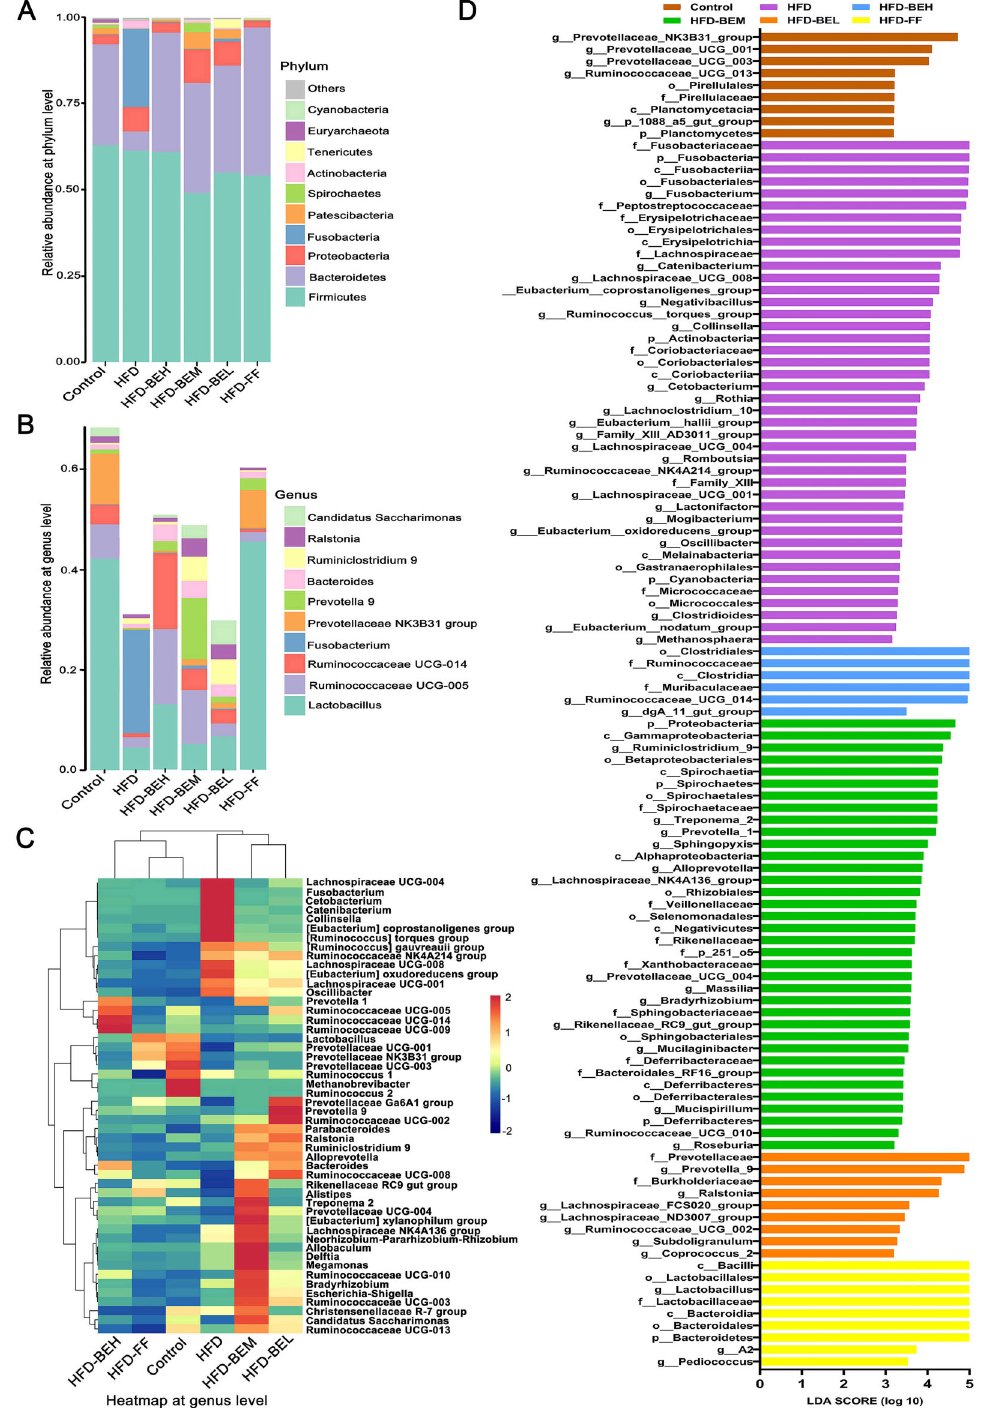
Figure 4. Effect of berberine and evodiamine (BE) at high, medium, and low doses (BEH, BEM, BEL) or feno fi brate (FF) on the structure of gut microbiota animals fed a high-fat diet (HFD). Bacterial taxa of relative abundance at ( A ) phylum level and ( B ) genus level. C , Heatmap of abundance at genus level. D , Linear discriminant analysis (LDA) effect size (LEfSe)